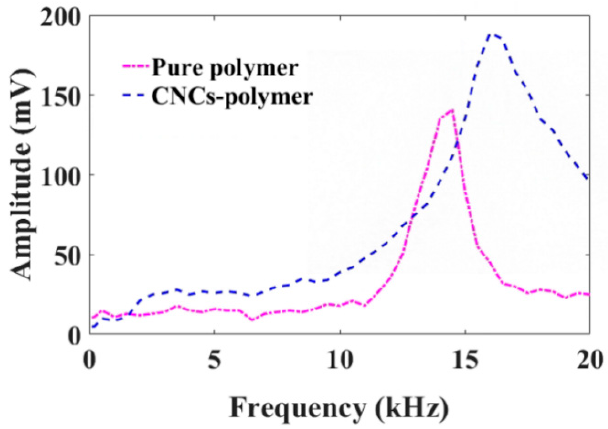
Figure 8. Frequency response of the fabricated FPI acoustic sensor.